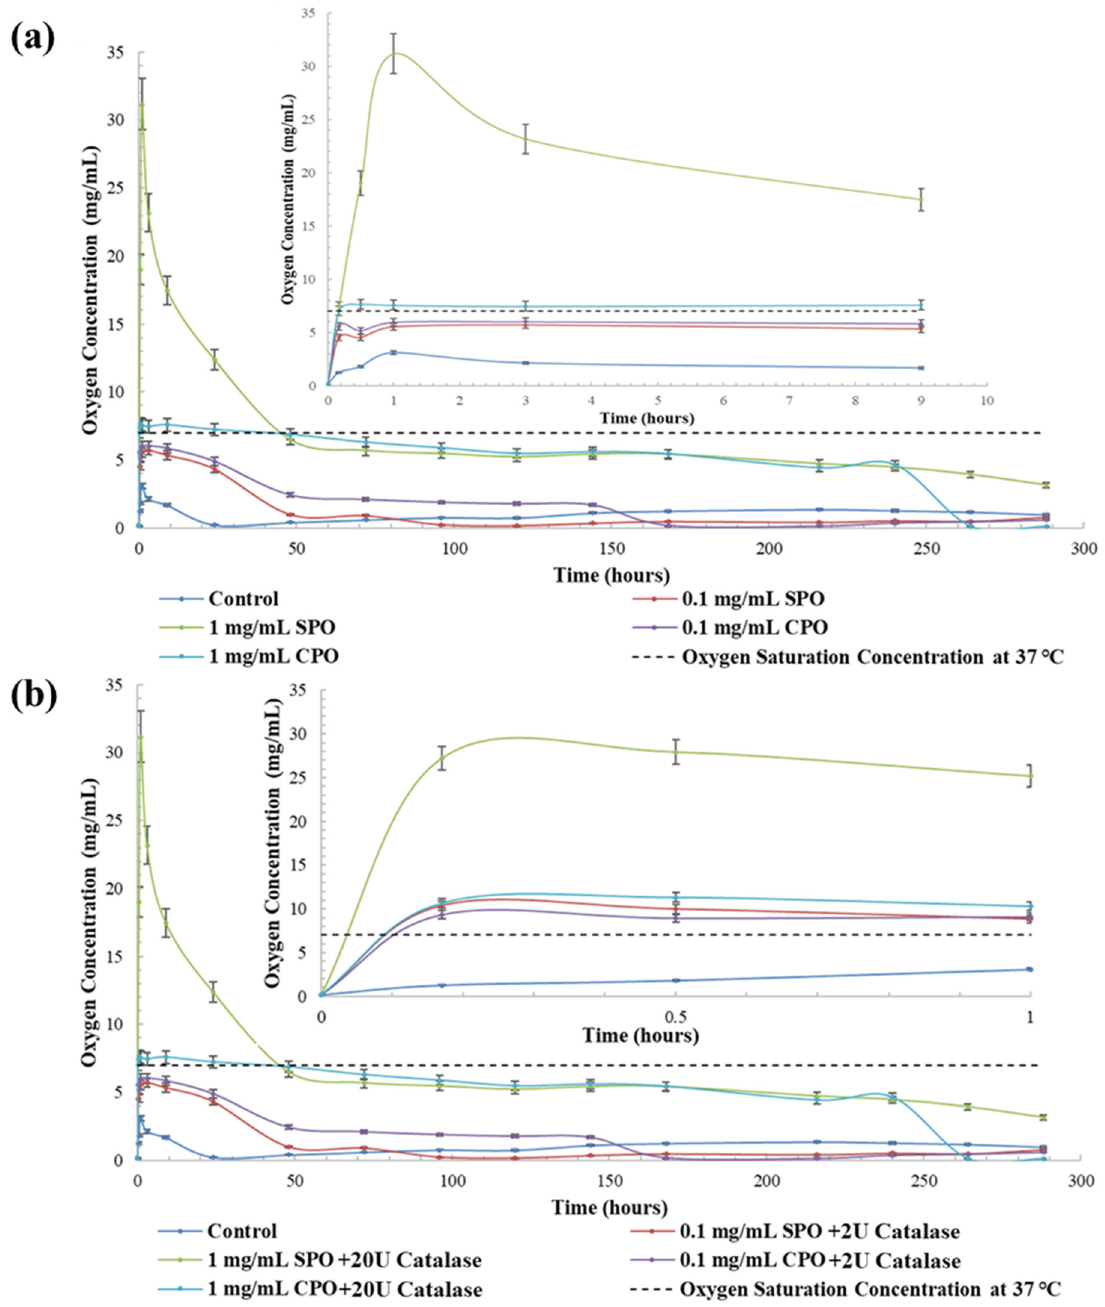
Figure 1. Oxygen release kinetics from ( a ) different concentrations of SPO and CPO and ( b ) different concentrations of SPO/catalase and CPO/catalase under a 0.1% O 2 hypoxic condition. Both demonstrate that the sample with 1 mg/mL SPO in each group had the highest initial burst and maintained release profile. Inset plots depict the initial burst release curve with higher temporal resolution.